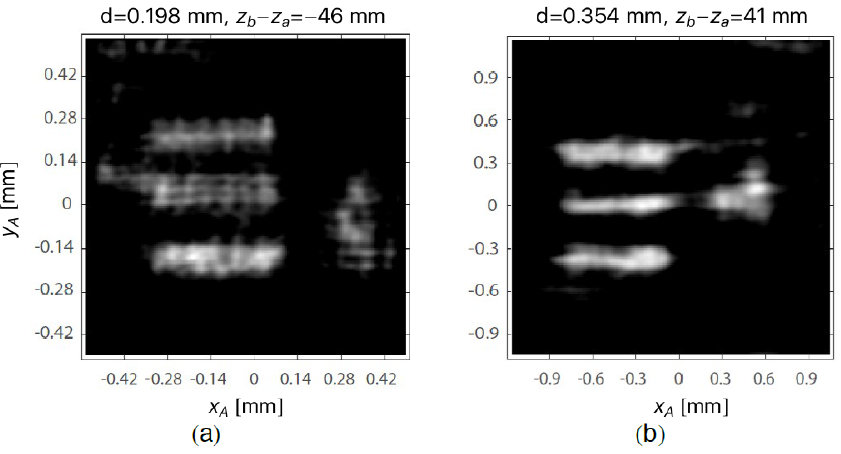
Figure 9. CPI images obtained in the experimental settings A and C of Figure 7, with the setup reported in Figure 10. The experimental data are taken with a pixel size at the diffraction limit ( δ x = 7.2 µ m), while the refocused images are characterized by an effective pixel size scaled by a factor z b / z a , in line with Equation (12). After correlation measurement, low-pass Gaussian filtering and thresholding in the Fourier domain was applied to remove an uncorrelated background. Experimental results were originally published in supplementary material of Ref. [42]. Reproduced with the permission from [42], copyright American Physical Society,